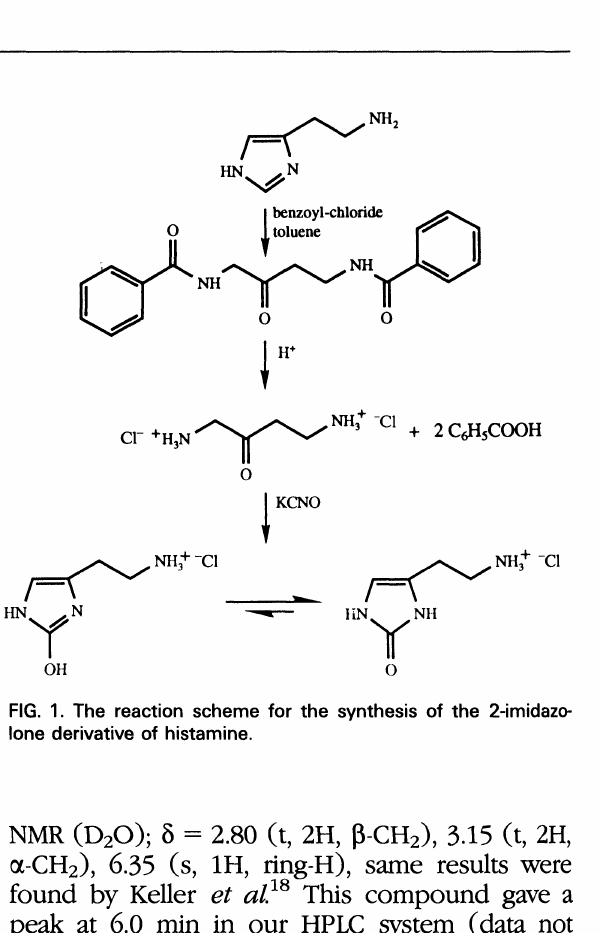
FIG. 1. The reaction scheme for the synthesis of the 2-imidazo- lone derivative of histamine.